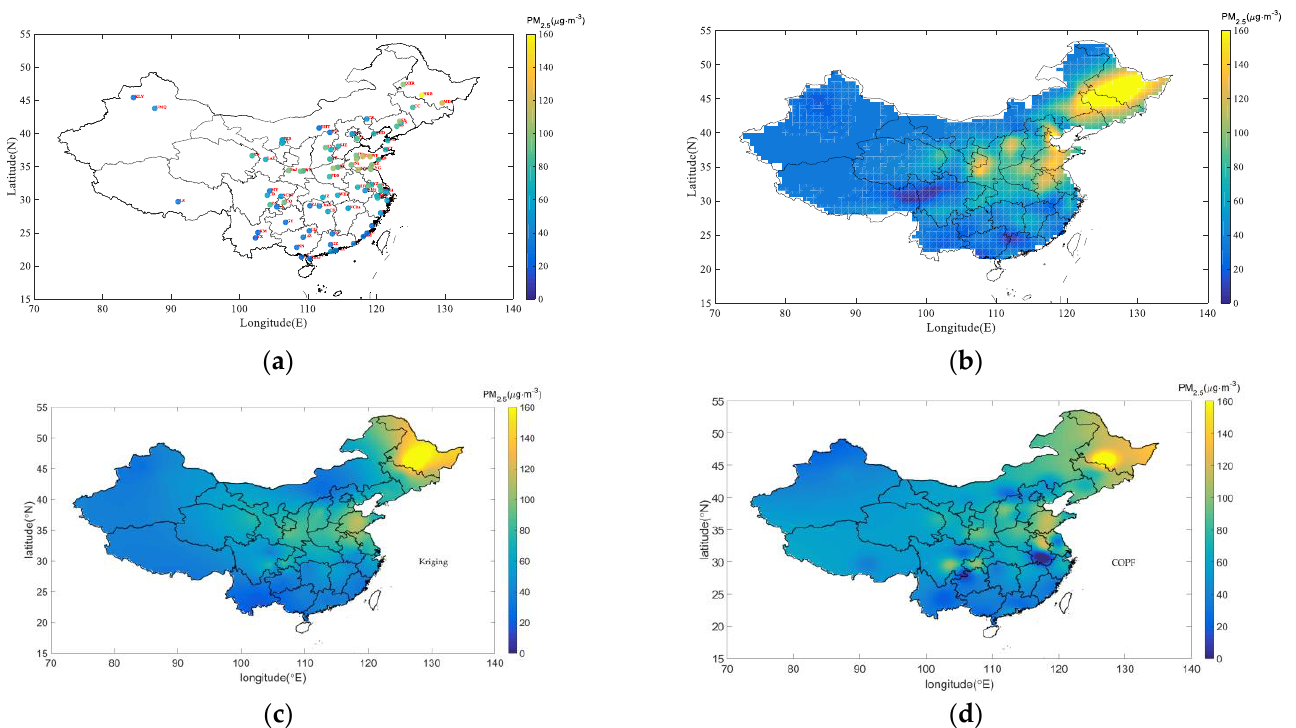
Figure 8. Mean observations of the 80 sample cities ( a ) and mean distribution of the simulated PM 2.5 on 8–11 November 2014 ( b – d ).